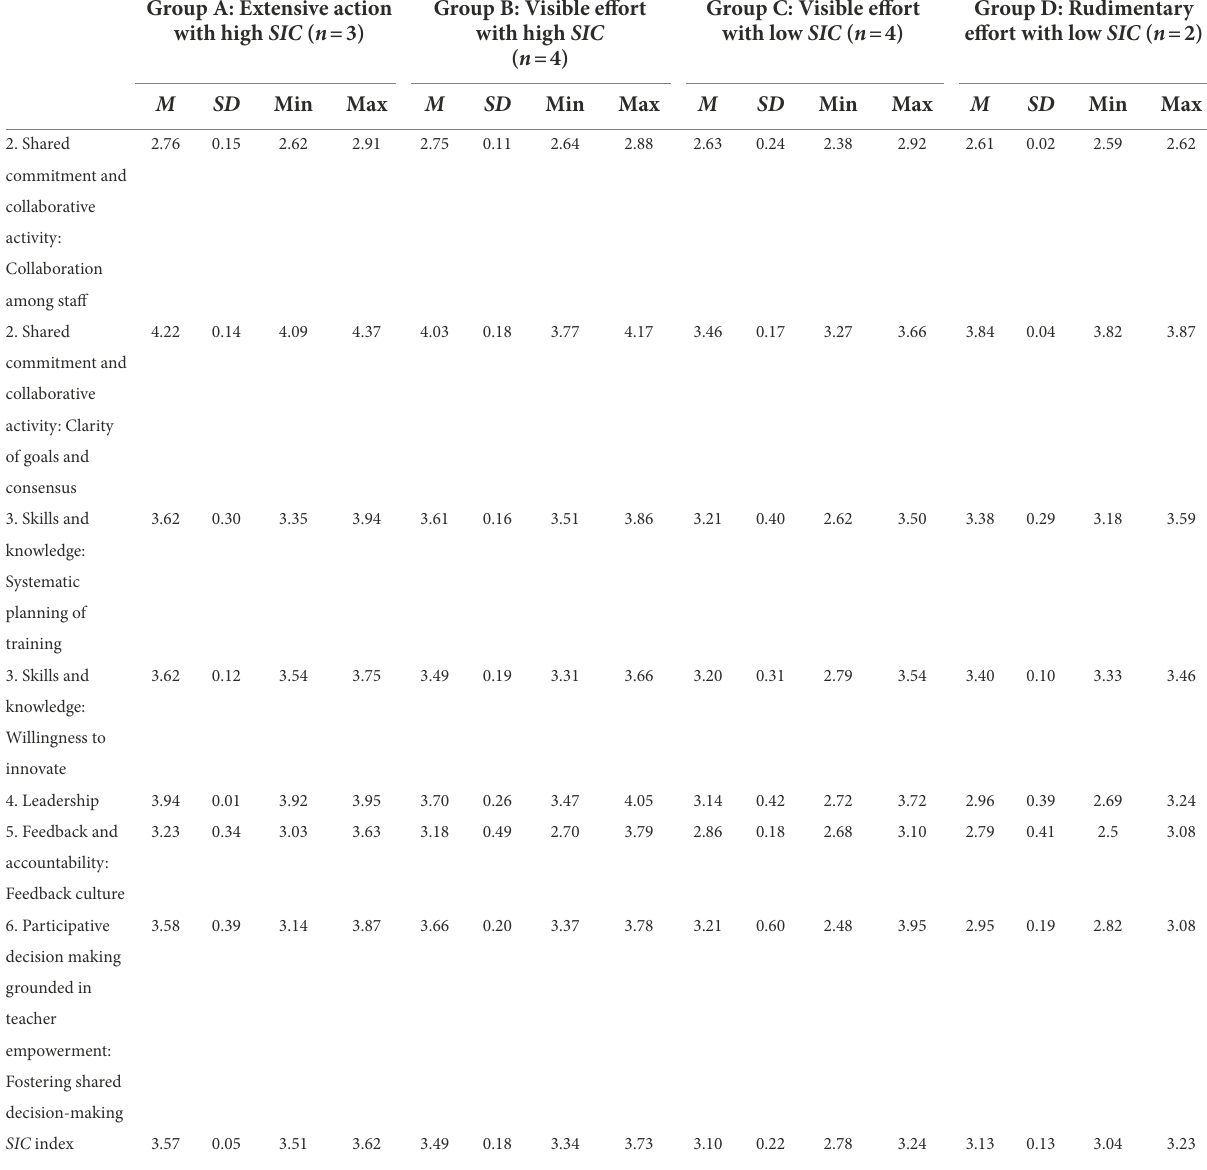
TABLE 6 Means and standard deviations for the six SIC dimensions by the four groups of schools. Group A: Extensive action with high SIC ( n = 3)